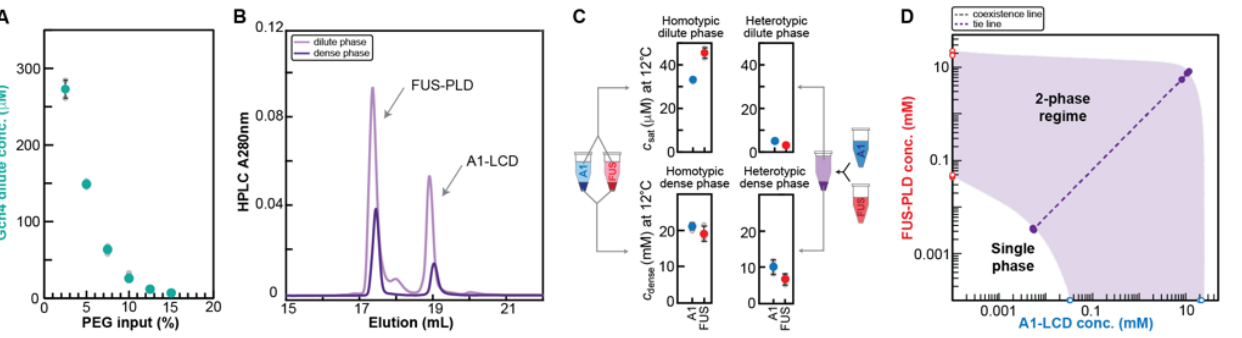
Figure 3. Determination of dilute and dense phase concentrations for multi-component systems. ( A ) Dilute phase concentrations of Gcn4 in the presence of increasing concentrations of PEG8000. Individual measurements are shown in grey, with the average shown in green. At least three replicates per sample were measured and error bars represent the standard deviation. ( B ) HPLC chromatogram showing the elution profile of samples of the dilute and dense phase for the A1-LCD/FUS-PLD mixture. The dense phase sample was diluted prior to injection. For a comparison of absorbance at 230 and 280 nm, please see Figure S2. ( C ) c sat and c dense for A1-LCD and FUS-PLD for the case of their homotypic or heterotypic phase separation. ( D ) Data points from C are shown in a 2D phase diagram. The tie line between coexisting dilute and dense phase concentrations in the heterotypic system is shown as dashed line. The 2-phase regime is approximated as shaded area as expected from few presented data points.